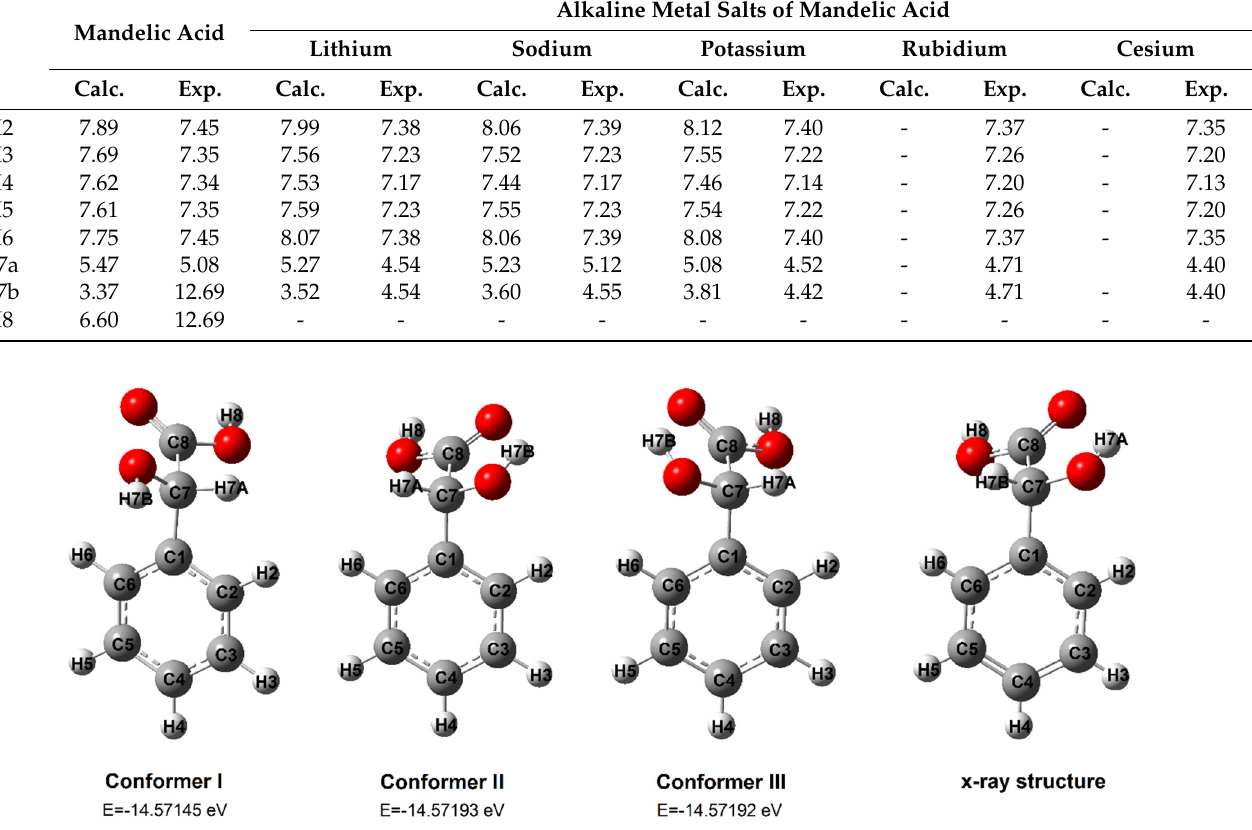
Figure 2. Conformers of mandelic acid (calculated in B3LYP/6-311++G(d,p)), and X-ray data struc- tures [30].